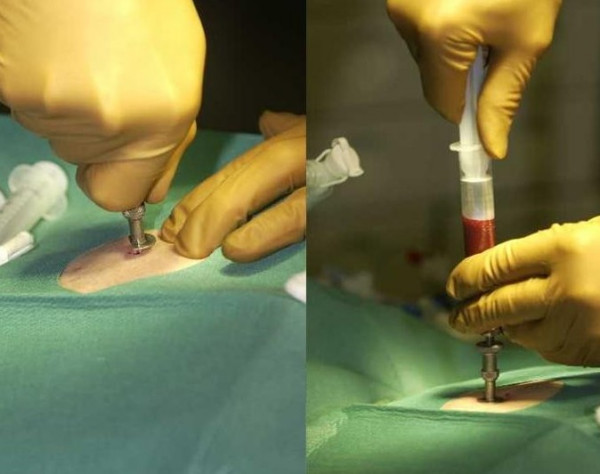
Bone marrow was harvested by sternal puncture prior to sternotomy.